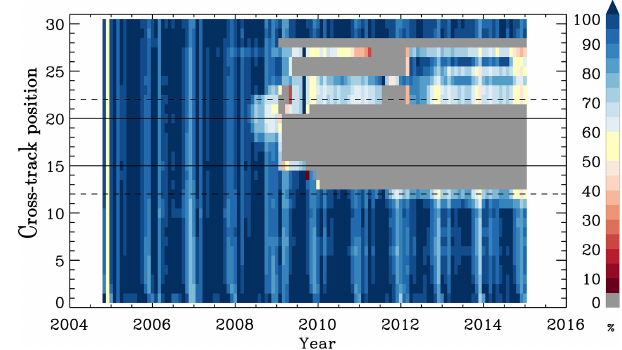
Figure 1. The monthly mean number of OMI retrievals at each cross-track position from October 2004 through December 2014, relative to the corresponding monthly mean number of OMI re- trievals in January 2005, i.e at the beginning of OMI operation. The solid lines represent the range of OMI–MLS collocations that vary from position 20 in the tropics to 15 at high latitudes, while the dashed lines represent the enforced post-RA OMI–MLS coinci- dence criteria (the closest OMI pixel from position ≤ 12 or ≥